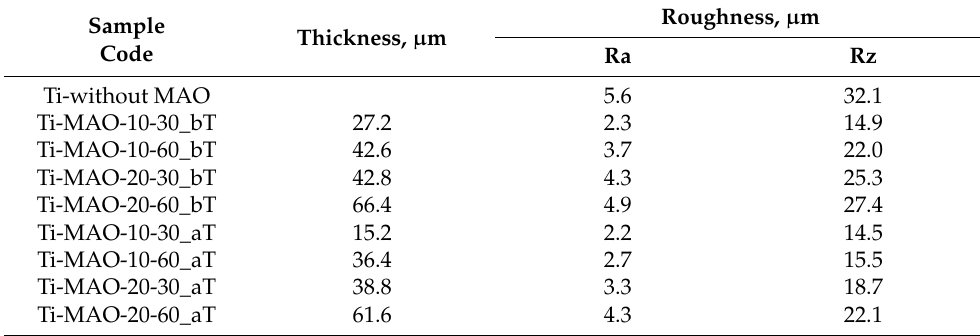
Table 3. Thickness and roughness of MAO coatings before (bT) and after (aT) TCT.